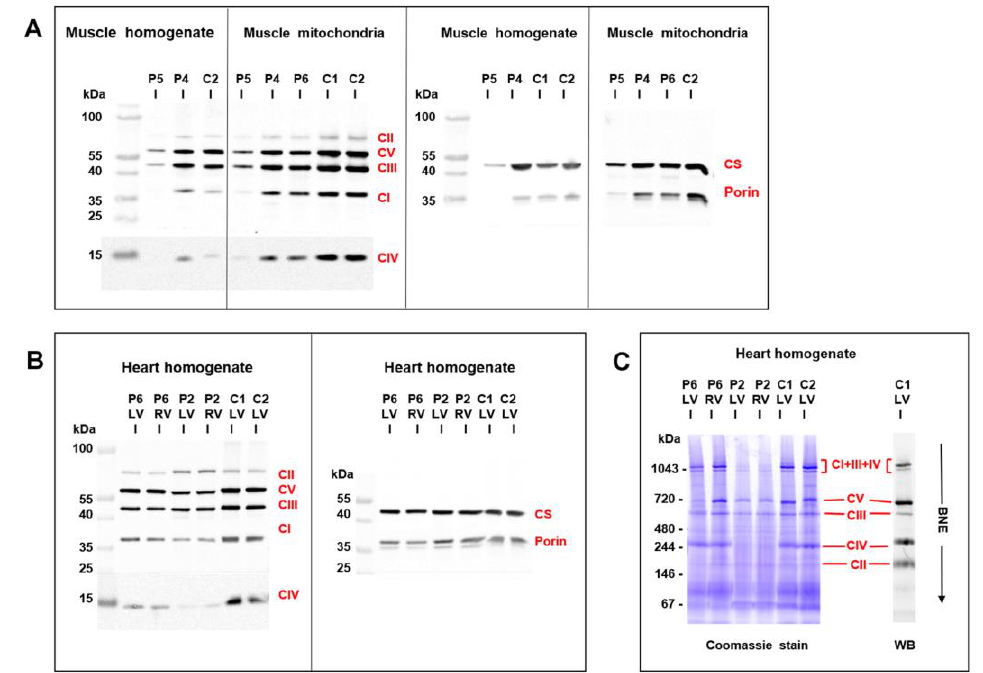
Figure 5. Western blot detection of mitochondrial proteins in skeletal muscle and heart. Analysis of SDS-PAGE resolved proteins from ( A ) muscle homogenates (6 µg protein aliquots) and isolated muscle mitochondria (2 µg protein aliquots) demonstrated a pronounced decrease of respiratory chain complexes (CI-CV), citrate synthase (CS), and porin in skeletal muscle of P5 compared to controls ( C ), P4 and P6 were less affected. Analysis of ( B ) heart homogenates (4 µg protein aliquots) from left and right heart ventricles (LV, RV) demonstrated a marked decrease of respiratory chain enzymes in P2 and a mild decrease in P6 compared to controls ( C ). CS and porin were less affected. BlueNative electrophoresis ( C ) further showed a marked decrease of native respiratory supercomplexes consisting of CI + CIII + CIV in P2 heart ventricles (12 µg protein aliquots).